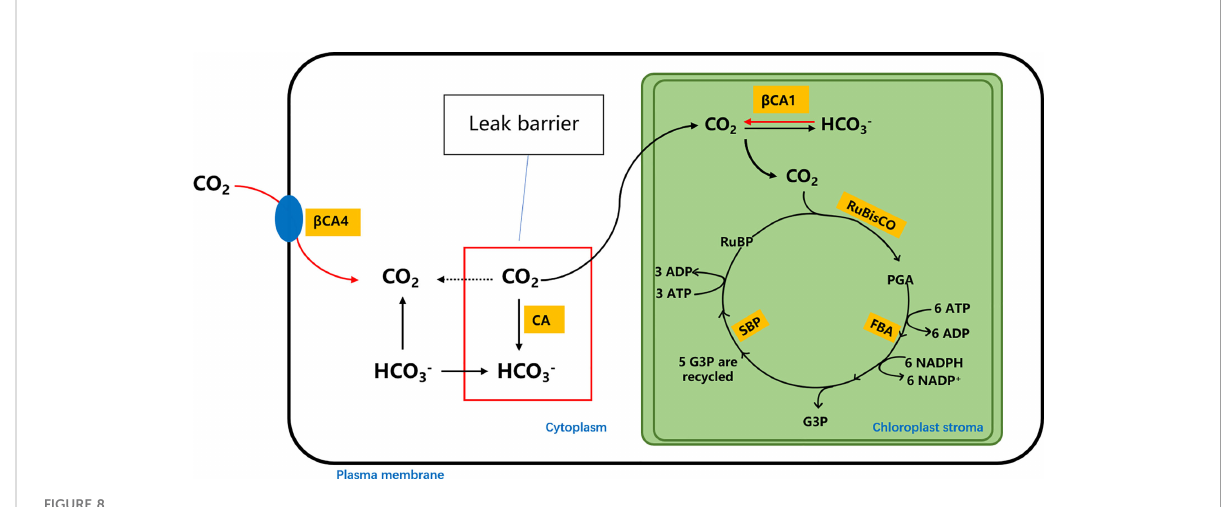
FIGURE 8 Superposition of plant photosynthetic carbon assimilation pathway. The highlighted part represents the locations of b CA1, b CA4, SBP and FBA